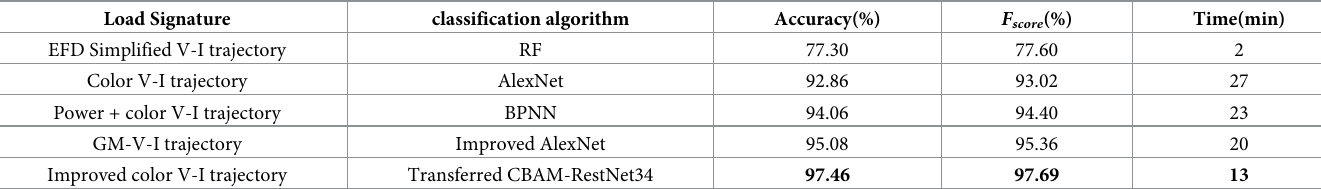
Table 4. The comparison of the proposed method and other power fingerprint identification